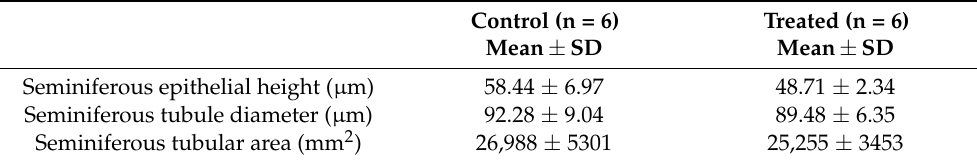
Table 4. Morphometry of young adult rams exposed to 25 µg of BPA/kg bw/day compared to control rams. The mean values and standard deviations (SD) are reported.